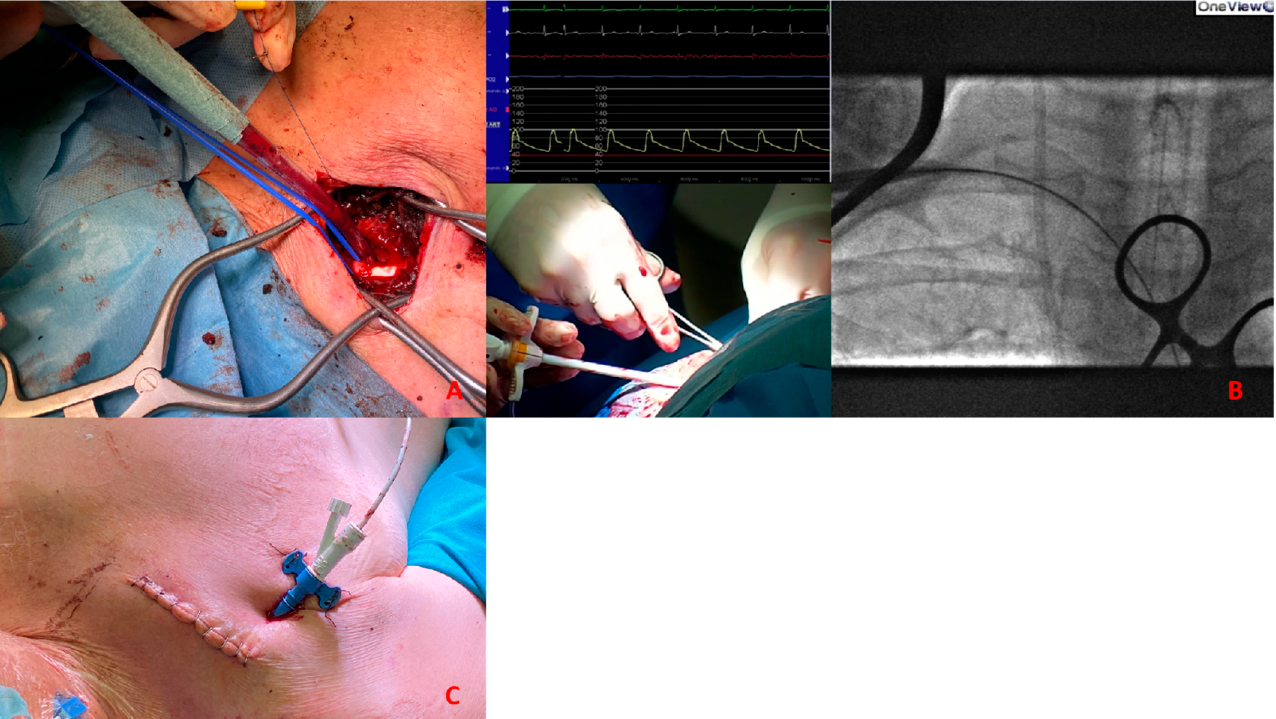
Figure 7. ( A ). Surgical exposure of subclavian artery. ( B ). Insertion of Impella CP sheath under fluor- oscopy guidance. ( C ). Placement of the sheath after tunnellization under the